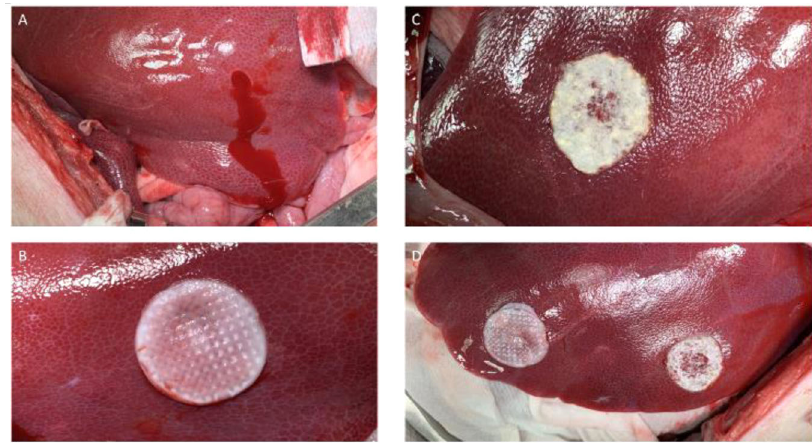
Fig. 5 Macroscopic photos from the in vivo porcine liver punch biopsy model. A Liver bleeding from a biopsy punch lesion without treat- ment. B Bleeding from a liver punch biopsy wound treated effectively with the autologous blood-derived patch. C Bleeding from a liver